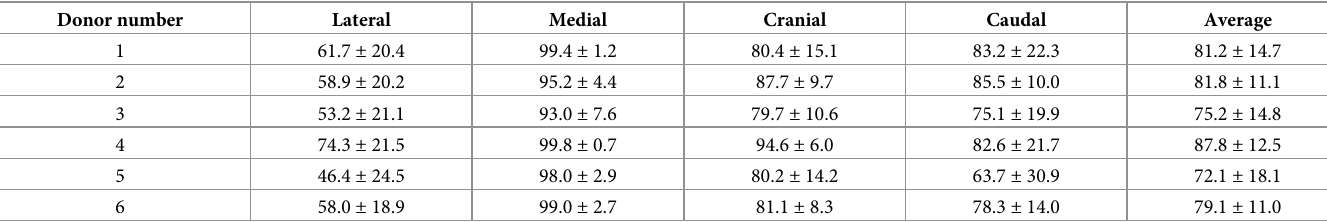
Table 3. Bone area fraction (%, mean ± SD) by